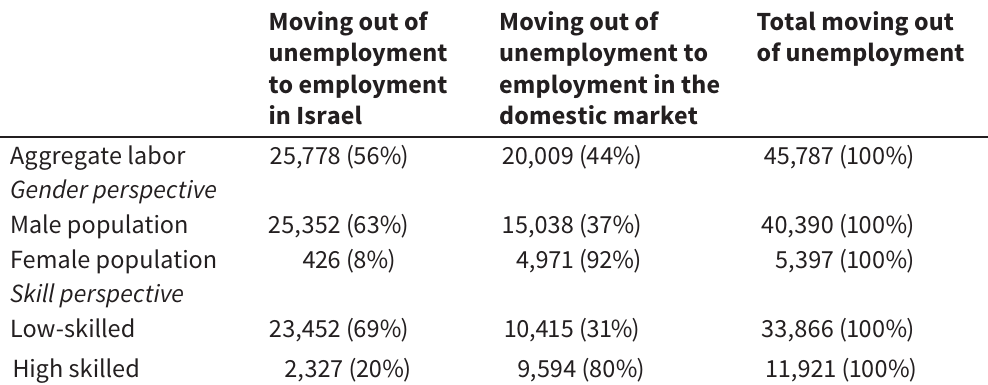
Changes in employment status (worker and percentage) among labor categories Moving out of